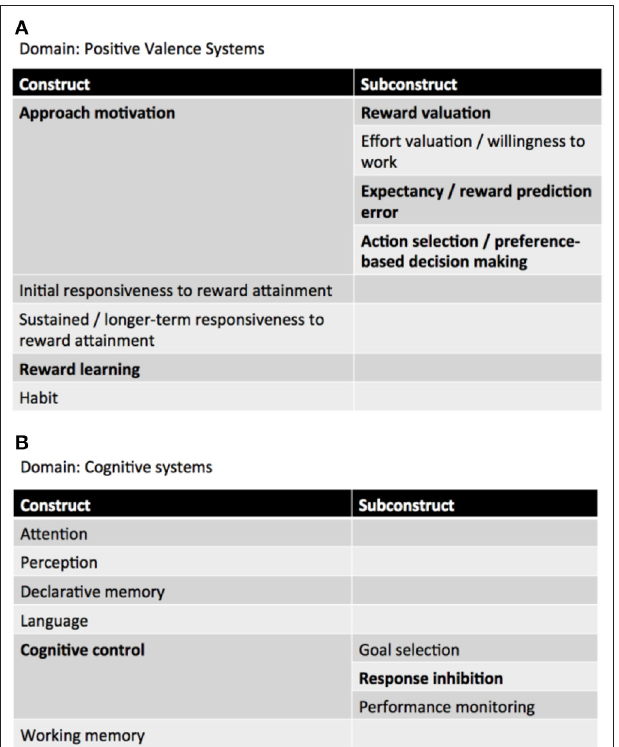
FIGURE 1 | RDoC domains involved in GD. (A) Positive valence systems, (B) cognitive systems (adapted from: NIMH RDoC Matrix https://www.nimh.nih. gov/research-priorities/rdoc/constructs/rdoc-matrix.shtml).